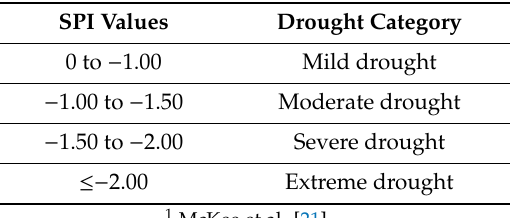
Table 4. SPI drought categories 1